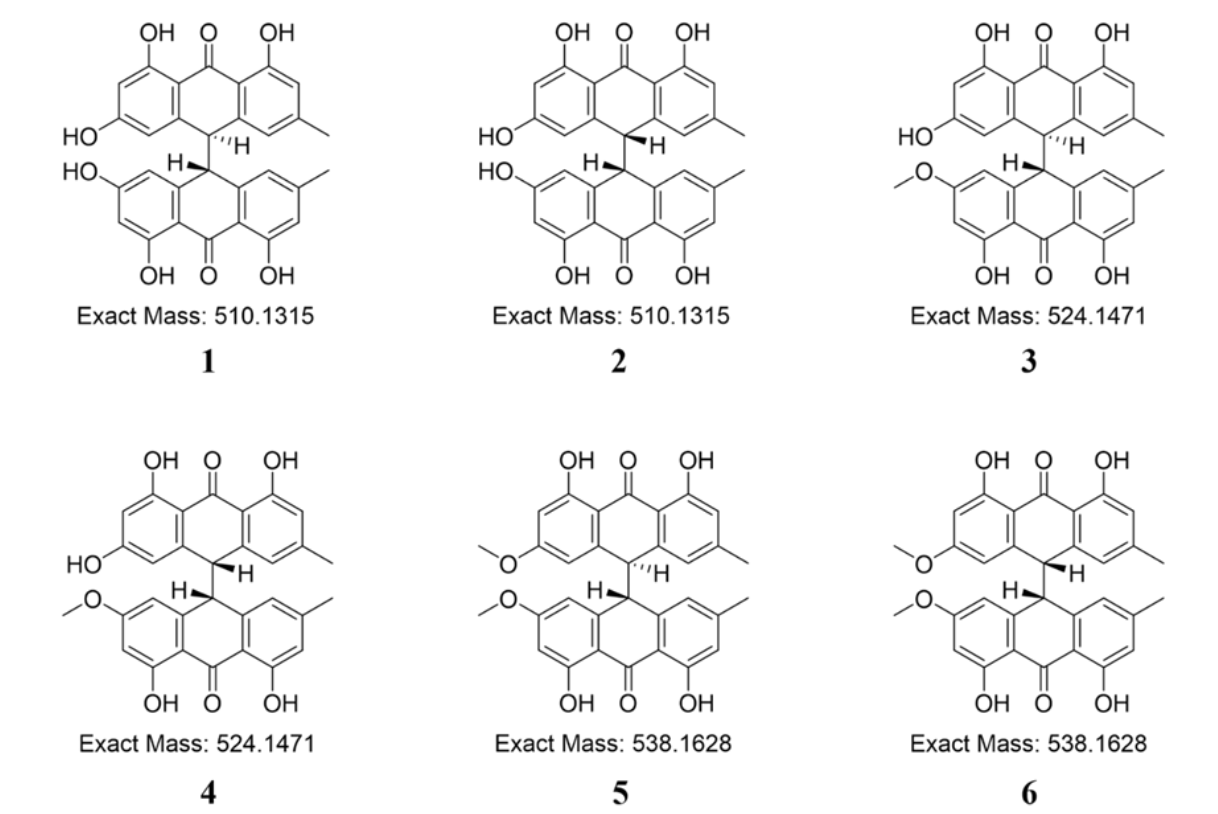
Figure 4. The chemical structure of six dianthrones (numbered 1–6). Trans -emodin-emodin dianthrones (1), cis -emodin-emodin dianthrones (2), trans -emodin-physcion dianthrones (3), cis -emodin-physcion dianthrones (4), trans -physcion-physcion dianthrones (5) and cis -physcion-physcion dianthrones (6).